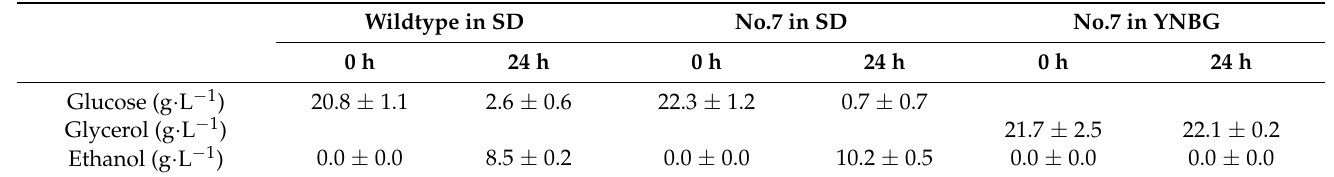
Table 1. Time-course profiles of carbon source consumption and ethanol production of wildtype and no.7 in each medium under anaerobic condition. Experimental replication was undertaken three times,